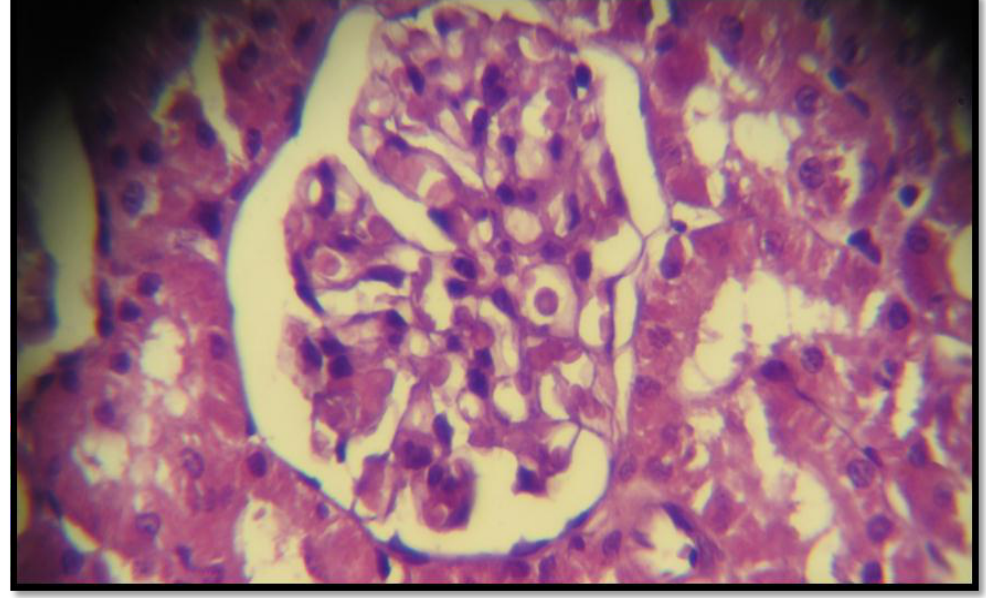
Figuer (8): Histological section in kidney at 21 days from treatment with acolholic extract of Plantago lanceolata showes no clear pathogenic lesion (E&H40X) As well as in bladder no clear pathological lesion except a few monocytes cell infiltration in subepithelial layer (Figure 9)